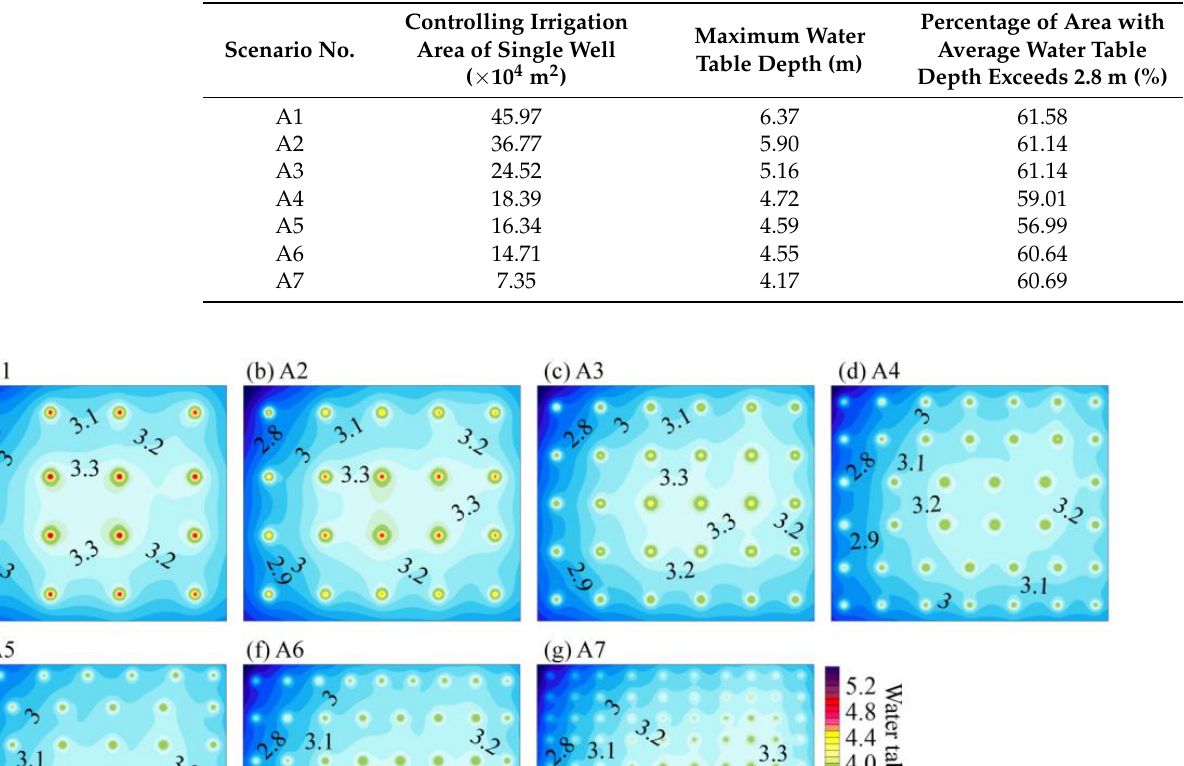
Table 6. The maximum water table depth and area proportion with average water table depth exceeds 2.8 m under the seven scenarios with different controlling irrigation area of single well.